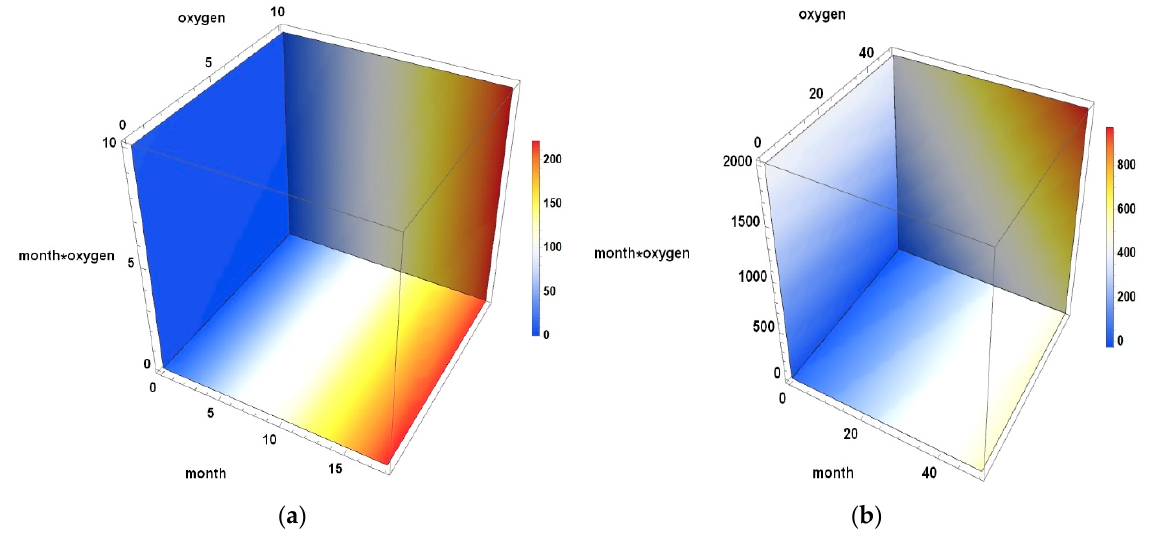
Figure 9. Predicted values of the corrosion depth obtained on the basis of regression models formed for the behaviour of the alloy under the influence of sea on NiTi1 ( a ) and NiTi2 alloy ( b ).